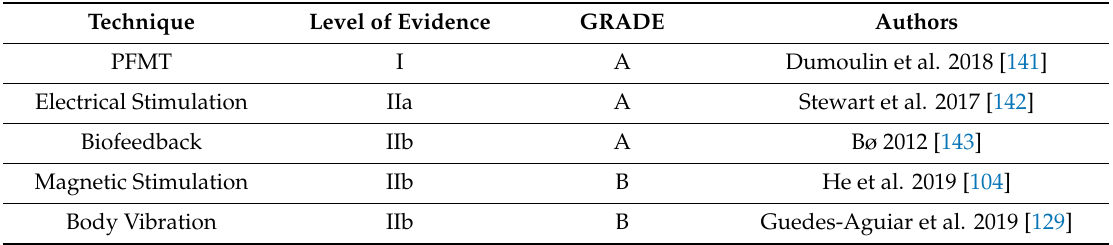
Table 7. Quality evidence of physiotherapy techniques in UI decisions in selected